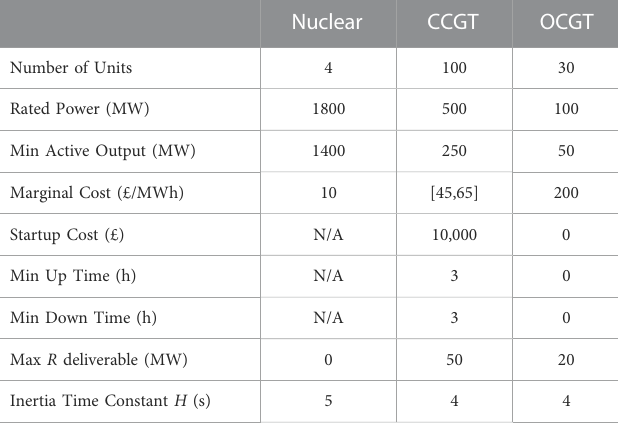
TABLE 1 Characteristics of thermal plants in GB ’ s 2030